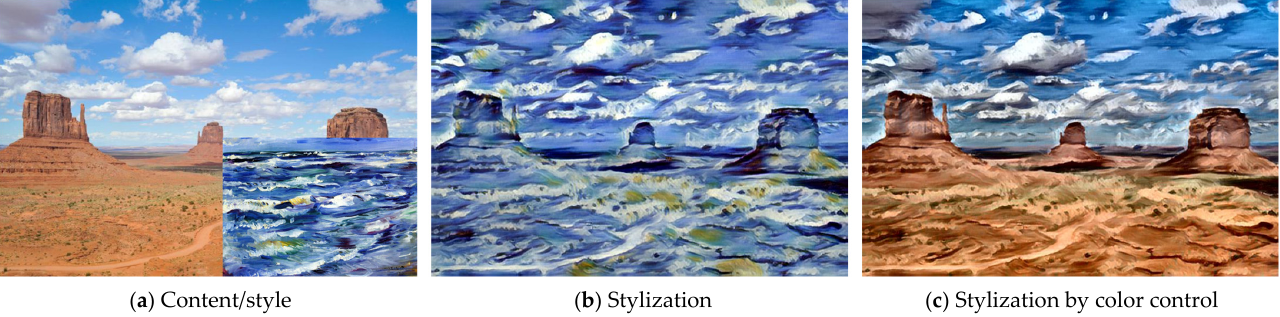
Figure 16. Color control.